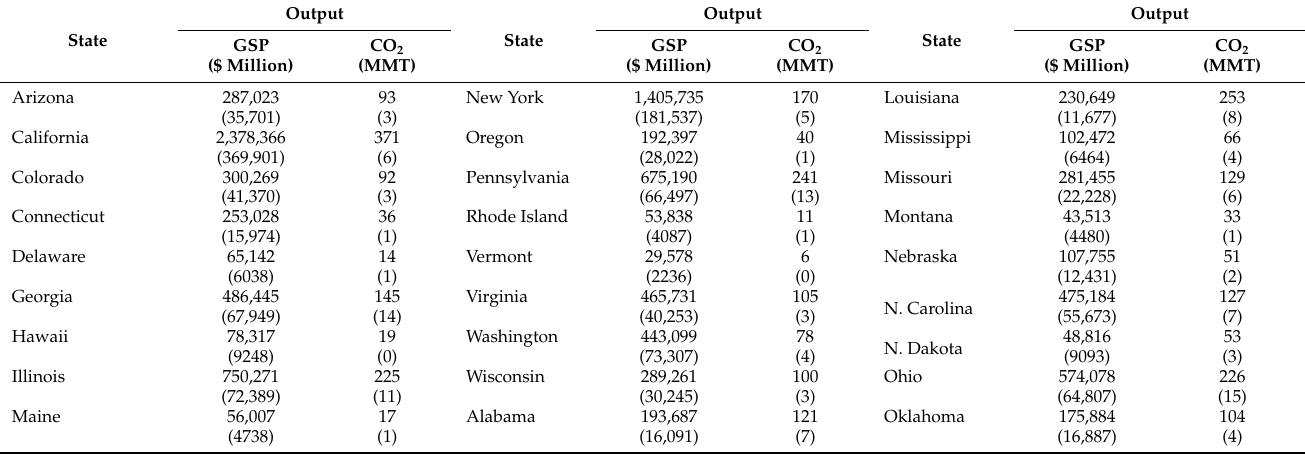
Table 5. Descriptive Statistics of 50 States’ Production Factors Data from